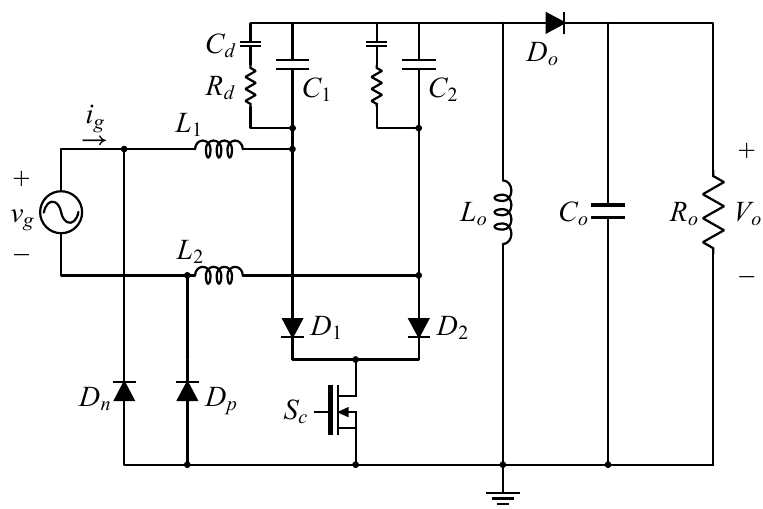
Figure 1. Topology of the bridgeless SEPIC PFC converter with the RC damping circuits. SEPIC: single-ended primary inductor converter; PFC: power factor correction.